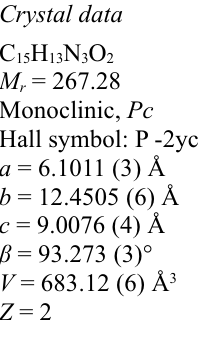
Packing of (I), showing the intermolecular hydrogen bonds as dashed lines.